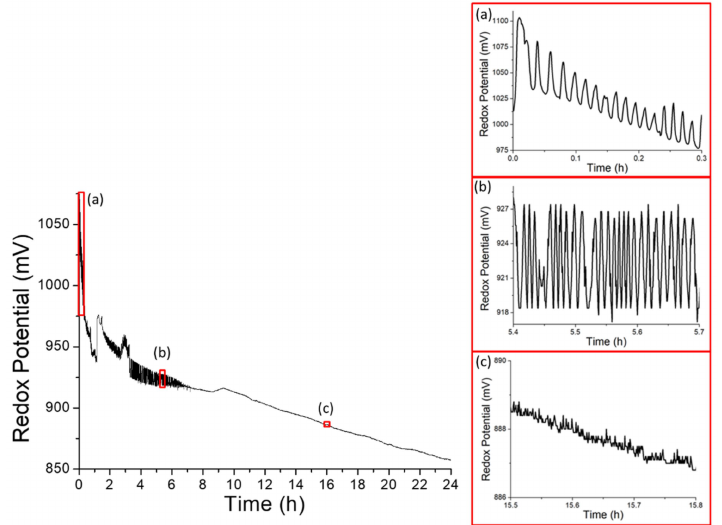
Figure 1. Oscillatory profile of the Belousov–Zhabotinsky (BZ) redox potential at 20 ± 1 ◦ C for the synthesis of PGMA- b -Ru(bpy) 3 - b -PHPMA triblock copolymer vesicles. Zoomed areas shows a detail of the oscillation of redox potential at di ff erent times: ( a ) 0 h, ( b ) 5 h and ( c ) 15 h. The solution contains MA (62.4 mM), NaBrO 3 (84 mM), and HNO 3 (300